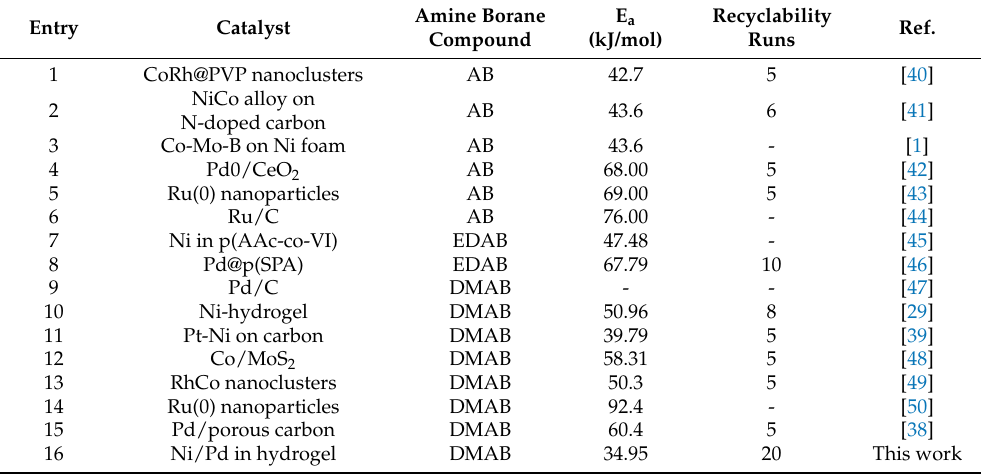
Table 4. Comparison of the E a and recyclability for the hydrolysis of amine borane compounds a